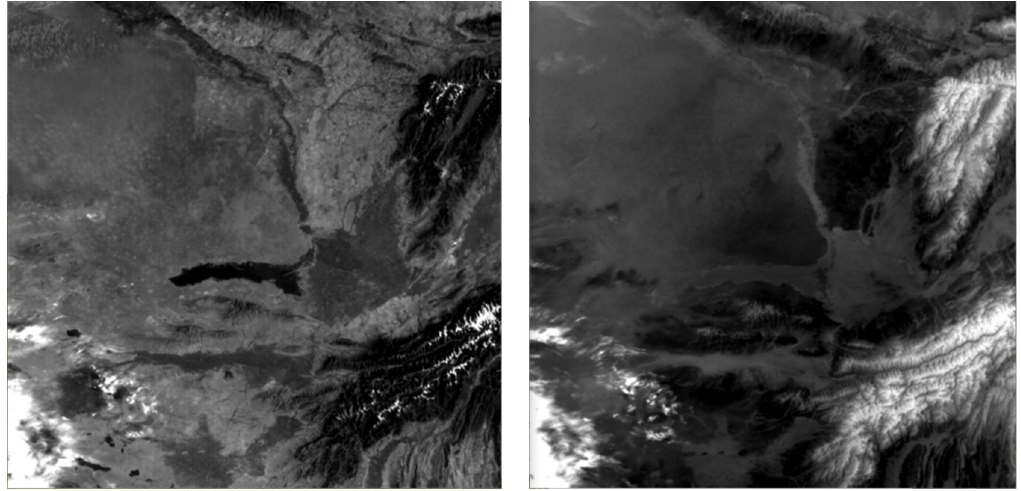
Figure 4. Reference bands 1 and 4 of FY1D.